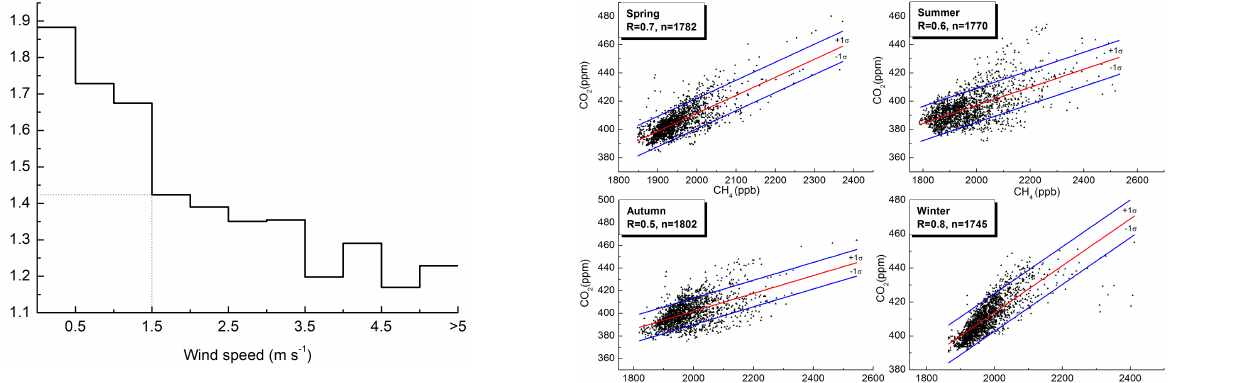
Figure 2. Average standard deviations of hourly CO 2 mole fractions versus wind speed based on all data from 10:00 to 16:00LT from 2009 to 2011. The standard deviations of hourly CO 2 data were calculated based on the 5min segments.